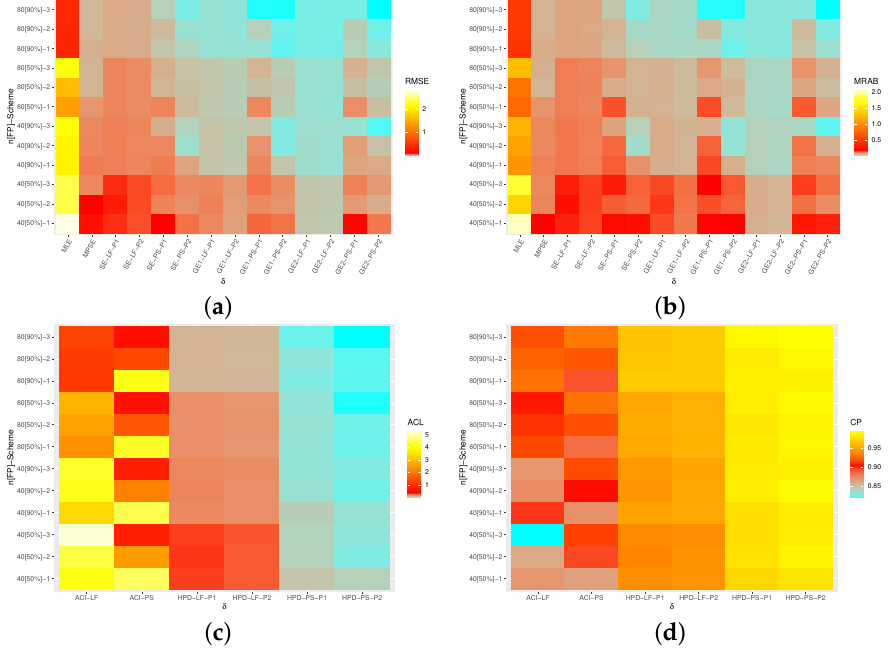
Figure 4. Heatmap for the simulation results of δ . ( a ) RMSE. ( b ) MRAB. ( c ) ACL. ( d )